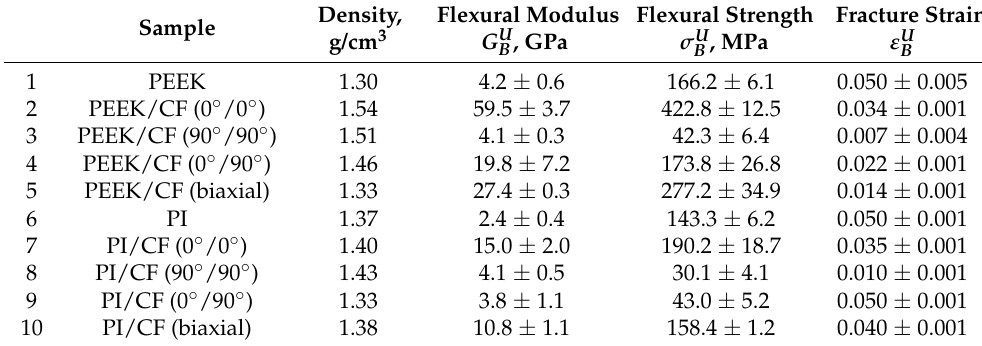
Table 3. The physical and mechanical properties of the CF reinforced composites and neat polymers.